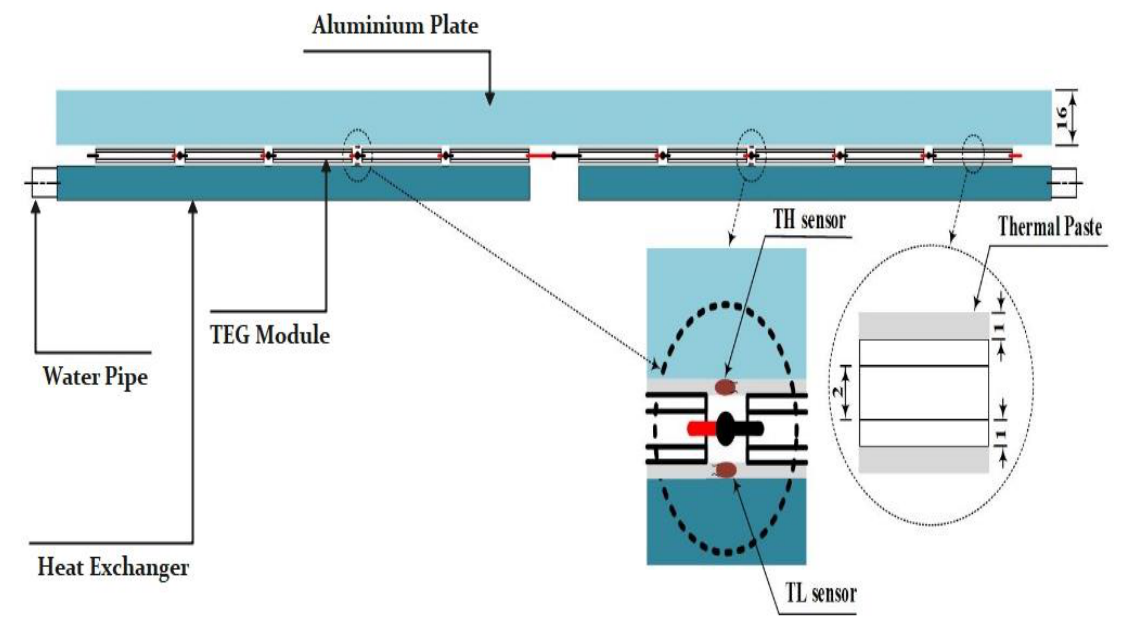
Figure 2. Cross-sectional schematic of the TEG panel.